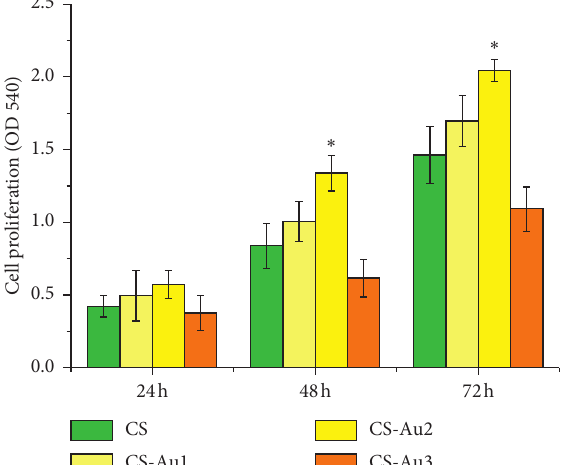
Figure 5: CCK-8 assays of Balb/c3T3 cells cultured on CS, CS/AuNPs 1 (2mg/mL), CS/AuNPs 2 (5mg/mL), and CS/AuNPs 3 (10mg/mL), Error bars represent the mean ± SD ( n � 3; ∗ statistically significant difference, ∗ P < 0 . 05).